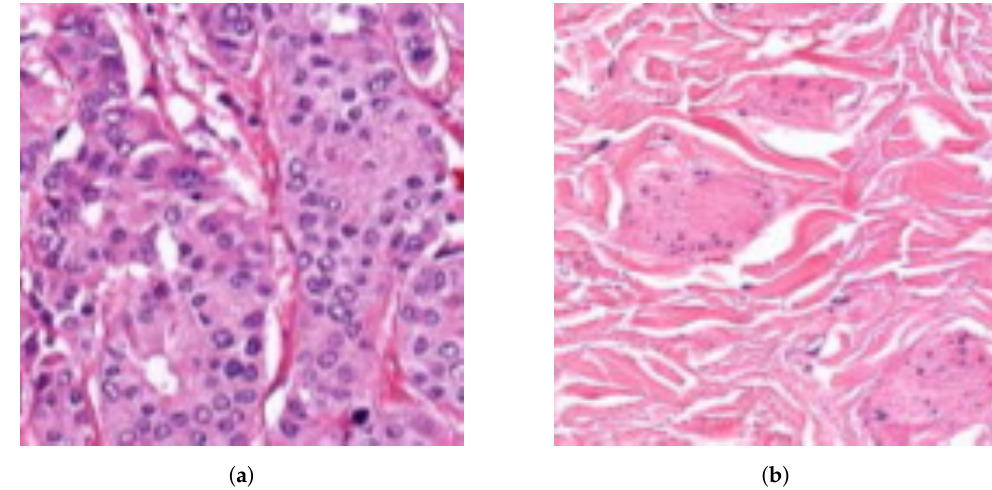
Figure 6. Examples of 128 × 128-pixel resolution histopathological image tile evaluations. ( a ) Image tile prediction: tumor confidence = 0.99 (tumor). ( b ) Image tile prediction: tumor confidence = 0.01